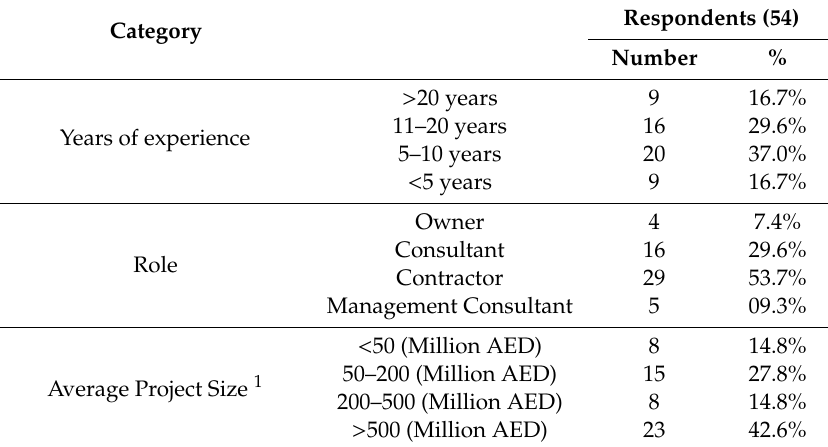
Table 1. Respondents’